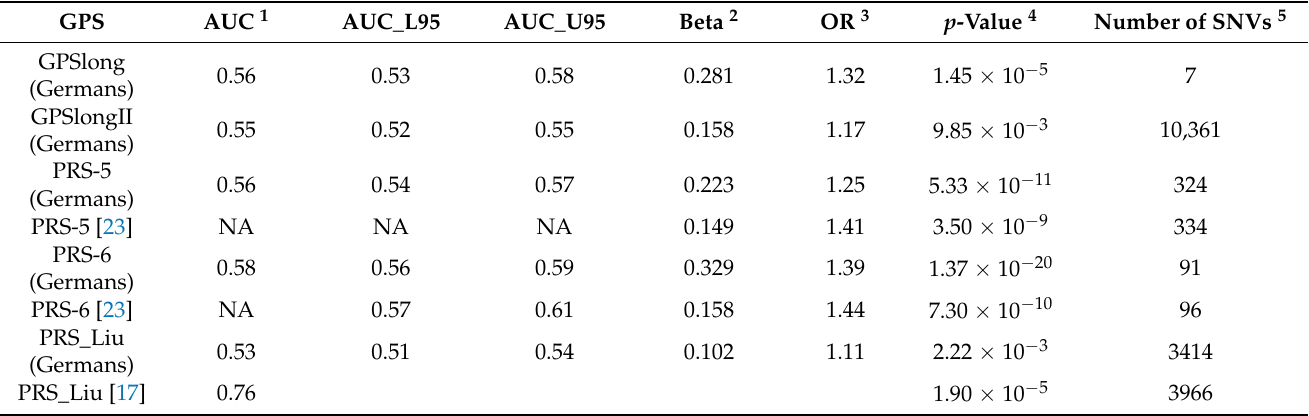
Table 2. Statistics of GPSlong and GPSlong II in the German cohort (test dataset) as well as the results of the replication of the previously published scores compared to the reference data